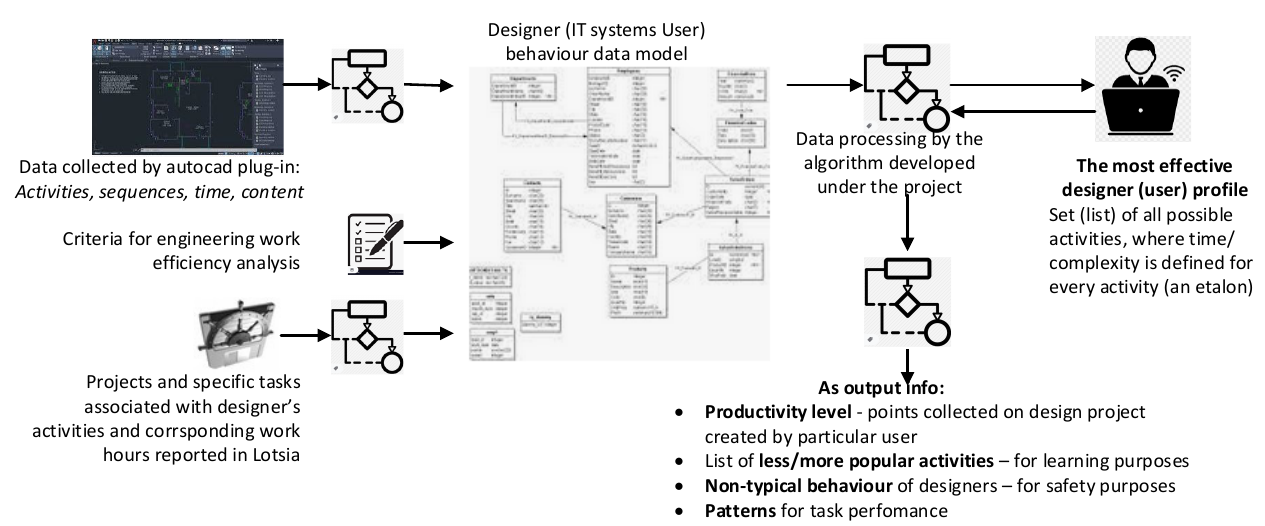
Fig. 2 . Conceptual schema of the approach for work efficiency estimation on the example of engineering system designer .